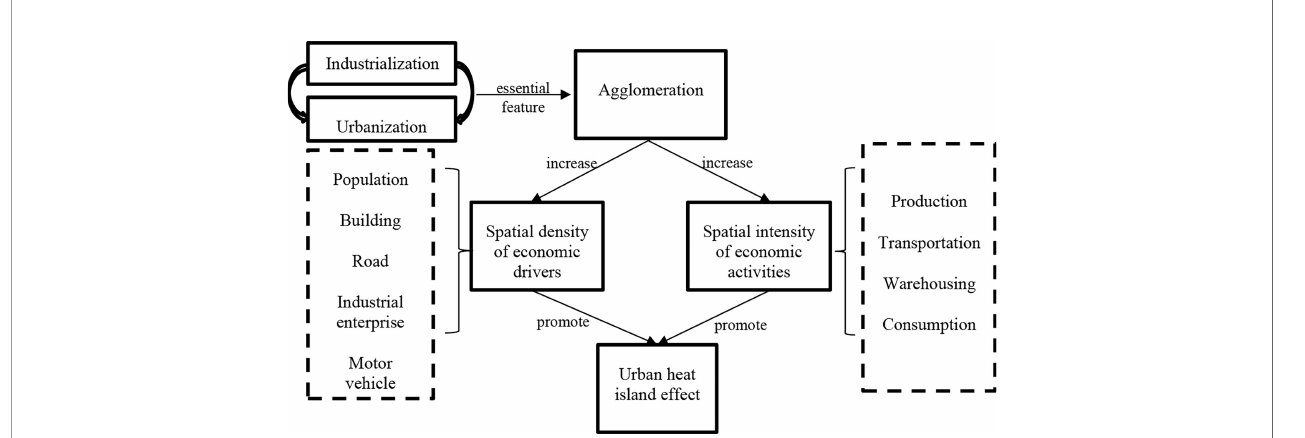
FIGURE 1 | The in fl uencing mechanism of economic drivers of UHI